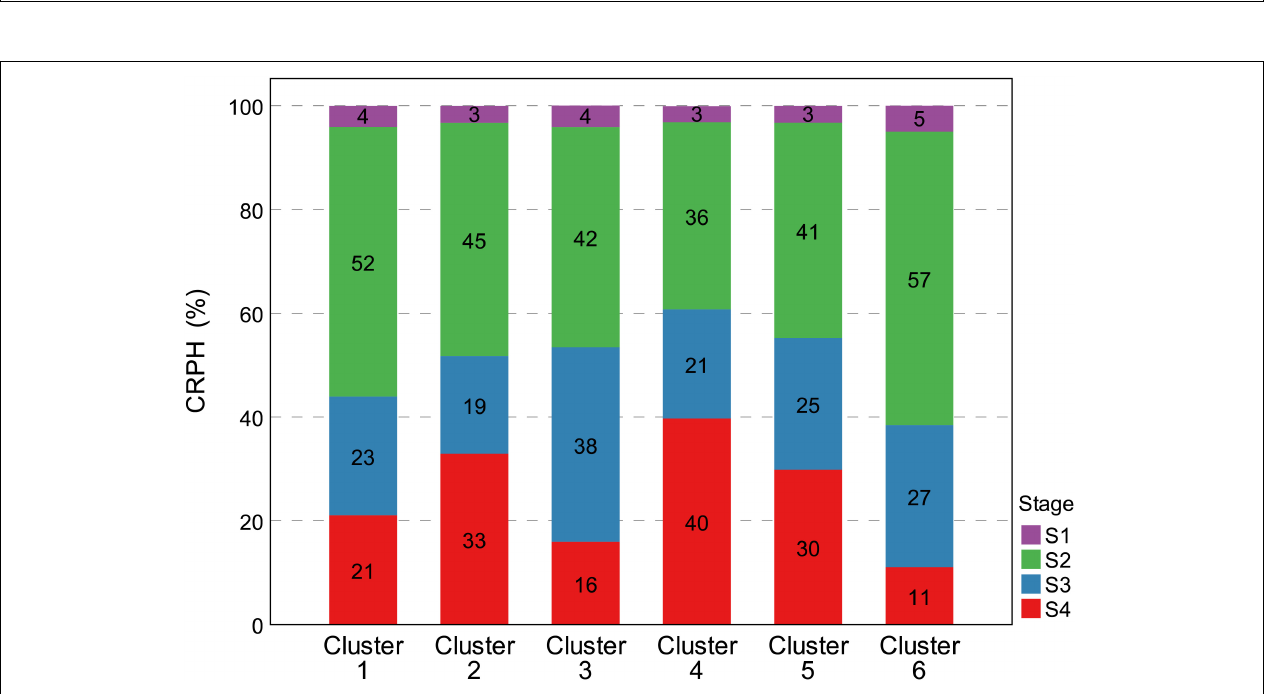
FIGURE 13 | Percentage distribution of CRPH trait in the six clusters during four growth stages. The vertical Y -axis represents the percentages distribution of CRPH at four growth stages, and the horizontal X -axis represents six clustering results of CRPH typical curve. The cumulative value of the Y -axis is 100%. All groups achieved the largest CRPH at the S2 growth stages. Cluster 2 and cluster 4 still retained higher plant height increment at the S4 growth stage. CRPH, contribution rate of plant height.